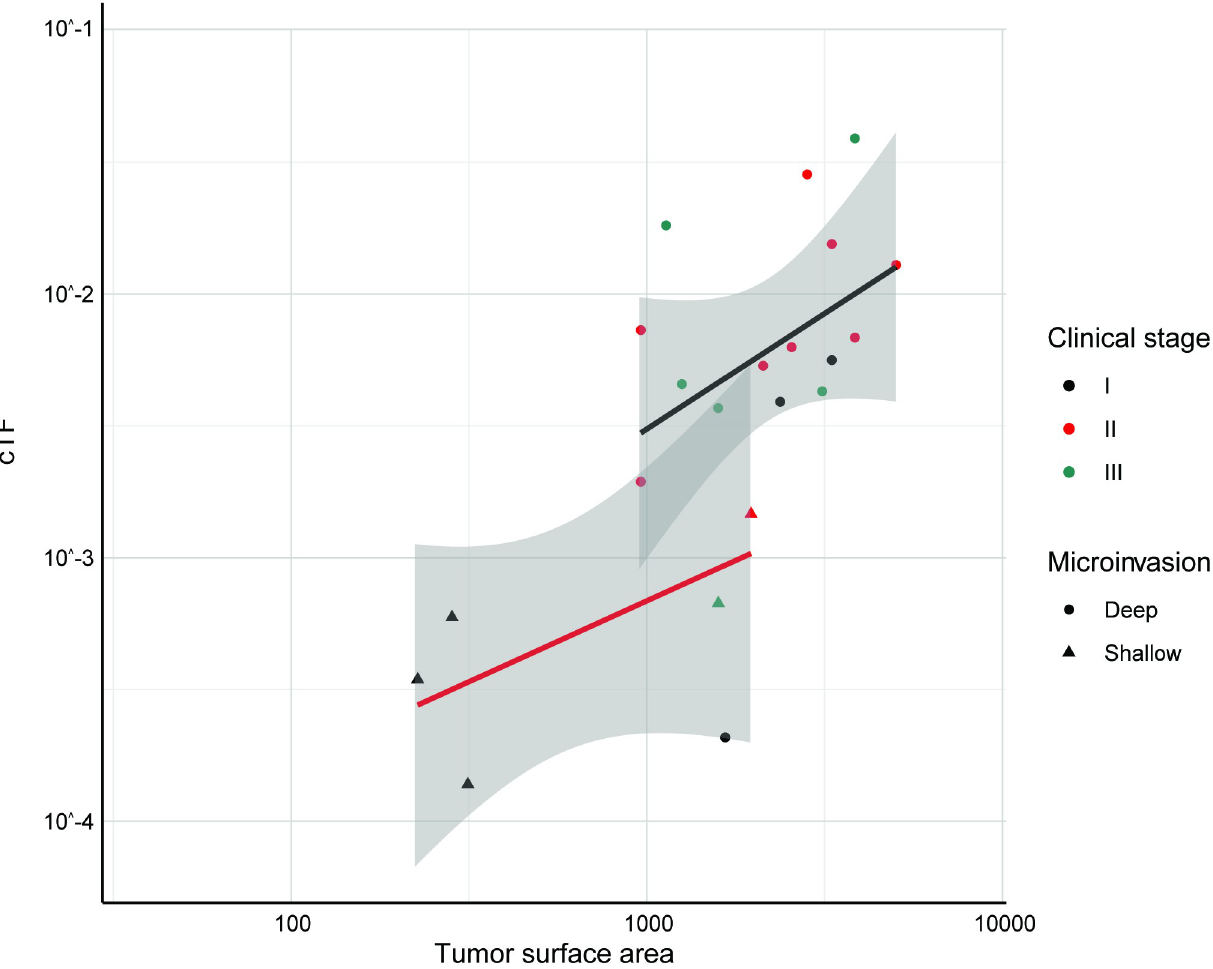
Fig 11. cTF increases with TSA and depth of microinvasion for colorectal cancer. cTF increased with TSA (in mm 2 ) and depth of microinvasion for colorectal adenocarcinomas. Dots show cases that invade beyond the subserosa, triangles show cases that do not invade beyond the subserosa. Black, red, and green dots depict samples from stages I, II, and III, respectively. (Model development and validation was limited to clinical stages I-III). Linear fit and 95% confidence intervals are shown in red (shallow microinvasion), black (deep microinvasion), and gray, respectively. cTF: Circulating tumor fraction, TSA: Tumor surface